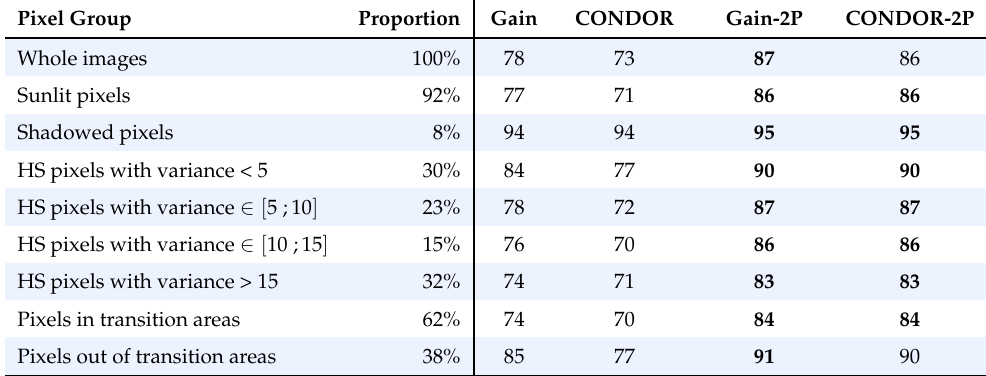
Table 5. “Gardanne” urban dataset: overall accuracy values (in %) for different pixel groups. Pixel